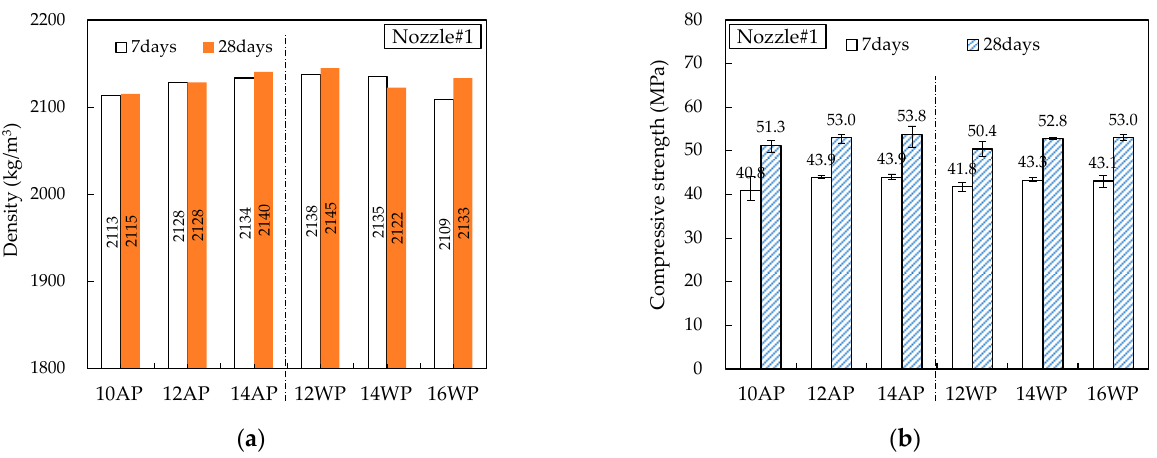
Figure 14. Hardened properties of Nozzle#1 specimens: ( a ) density; ( b ) compressive strength.